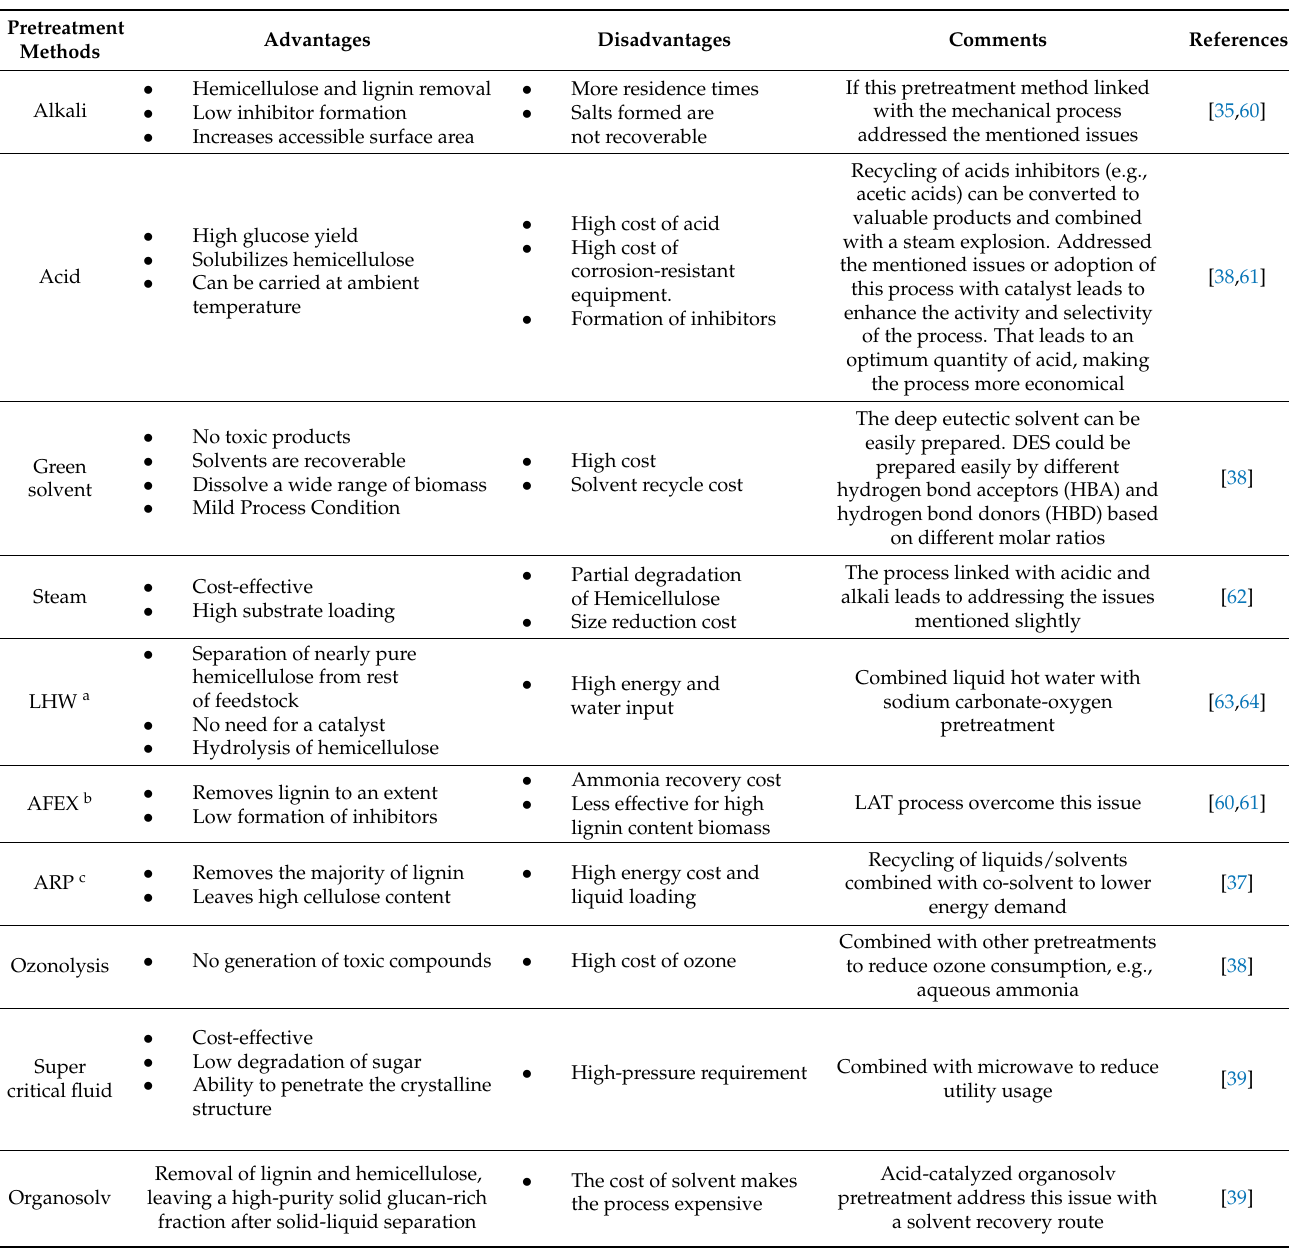
Table 2. Pretreatment of lignocellulosic biomass for